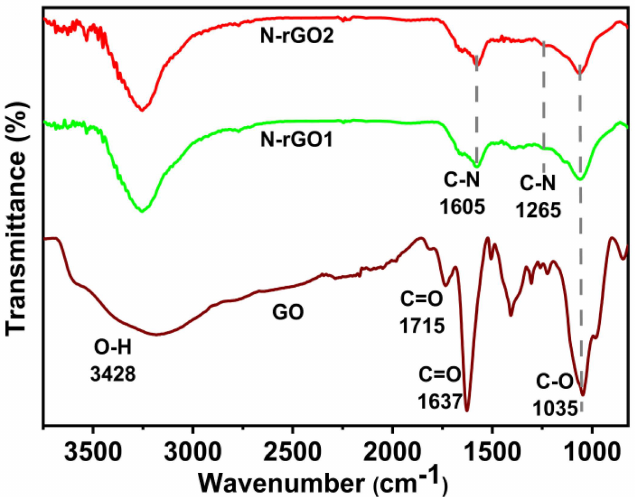
Figure 5. The graphical representation of the FTIR graph of GO, N-rGO-1, and